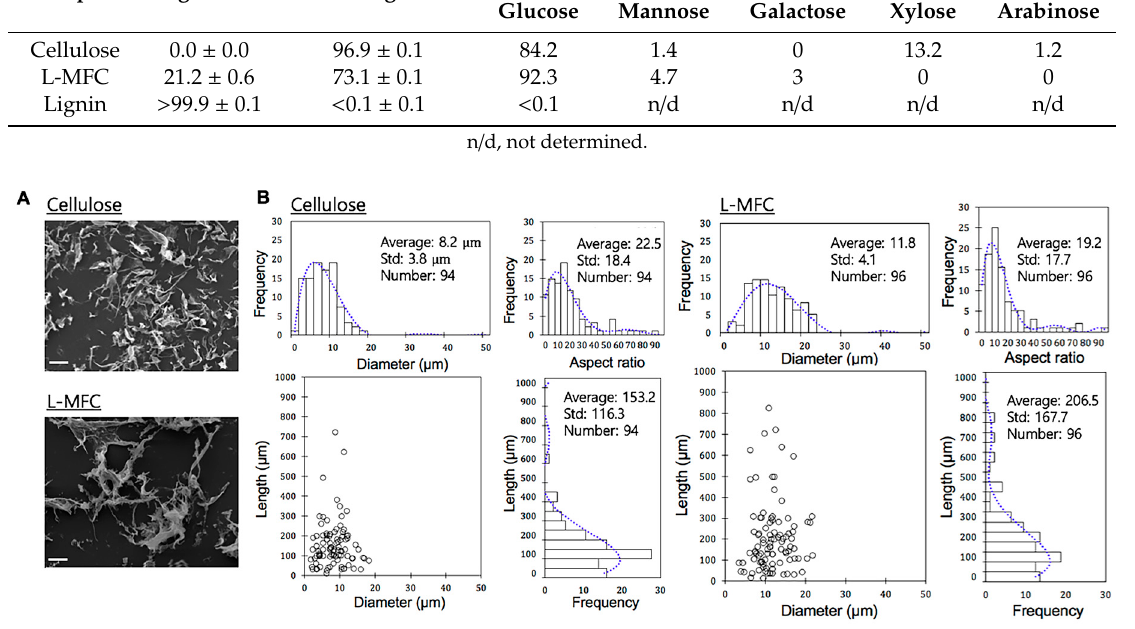
Table 2. Chemical compositions of cellulose, lignin-containing nanocellulose (L-MFC), and pure lignin. Samples